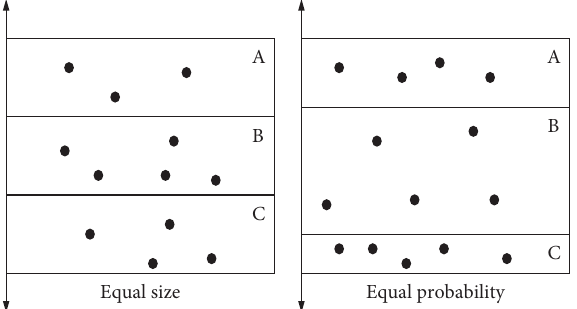
Figure 2: Discretization efects of diferent